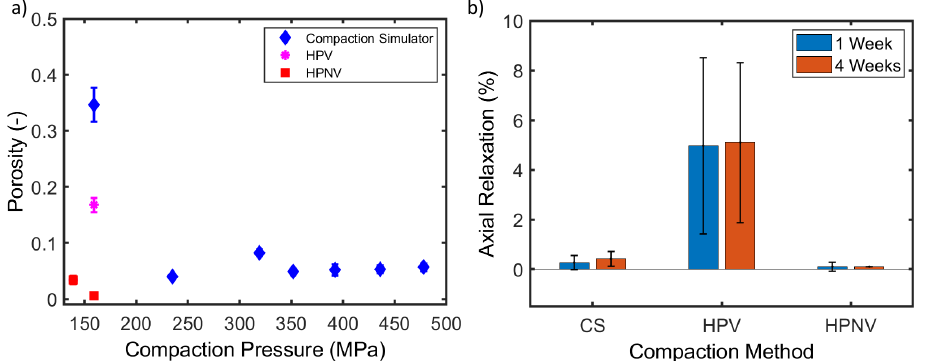
Figure 3. Sample porosity ( a ) and axial relaxation ( b ) of PTFE pellets. Three compaction methods were used: hydraulic press with a vacuum (HPV) and without a vacuum (HPNV), as well as a compaction simulator (CS). Values plotted are the mean with the error bars depicting ± one standard deviation ( n = 10 ( a ), n = 3 ( b )).